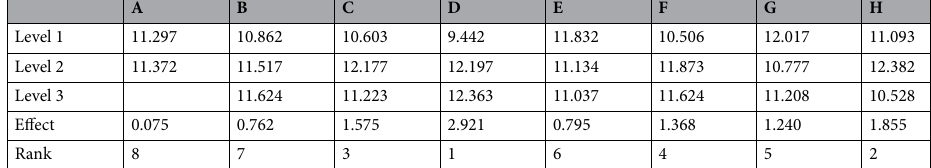
Table 3. Factor response table. A. Cross-linking volume ratio (Sodium alginate: CaCl 2 ), B. Sodium alginate solution concentration, C.